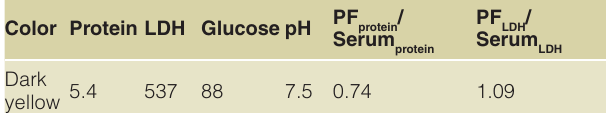
Table 3. Flow cytometry differential of leukocyte population demonstrating low immunophenotypic values of lymphocytes and granulocytes which demonstrates an unfavorable cytogenetic